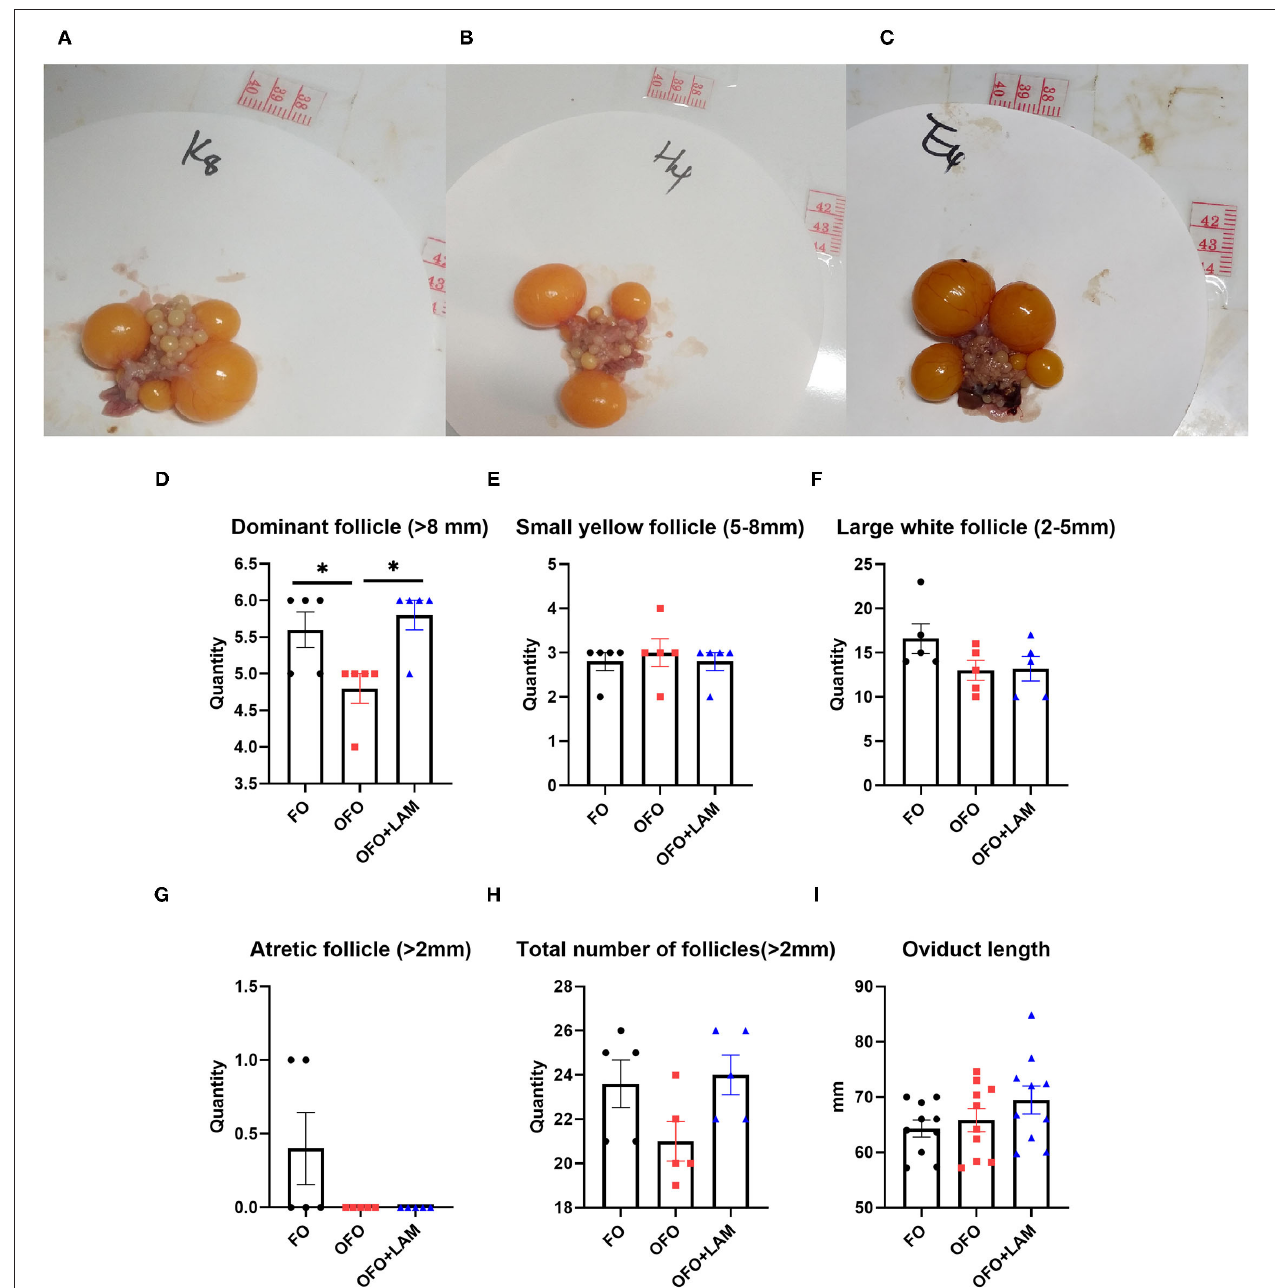
FIGURE 6 | Effect of FO, OFO, and OFO with LAM on ovary and oviduct of old laying hen. Ovary figure in FO (A) , OFO (B) , and OFO + LAM (C) . (D) Number of dominant follicle ( > 8mm) in FO, OFO, and OFO + LAM. (E) Number of small yellow follicle (5–8mm) in FO, OFO, and OFO + LAM. (F) Number of large white follicle (2–5mm) in FO, OFO, and OFO + LAM. (G) Number of atretic follicle ( > 2mm) in FO, OFO, and OFO + LAM. (H) Total number of follicle ( > 2mm) in FO, OFO, and OFO + LAM. (I) Oviduct length in FO, OFO, and OFO + LAM. * p < 0.05 indicates significant differences between the two